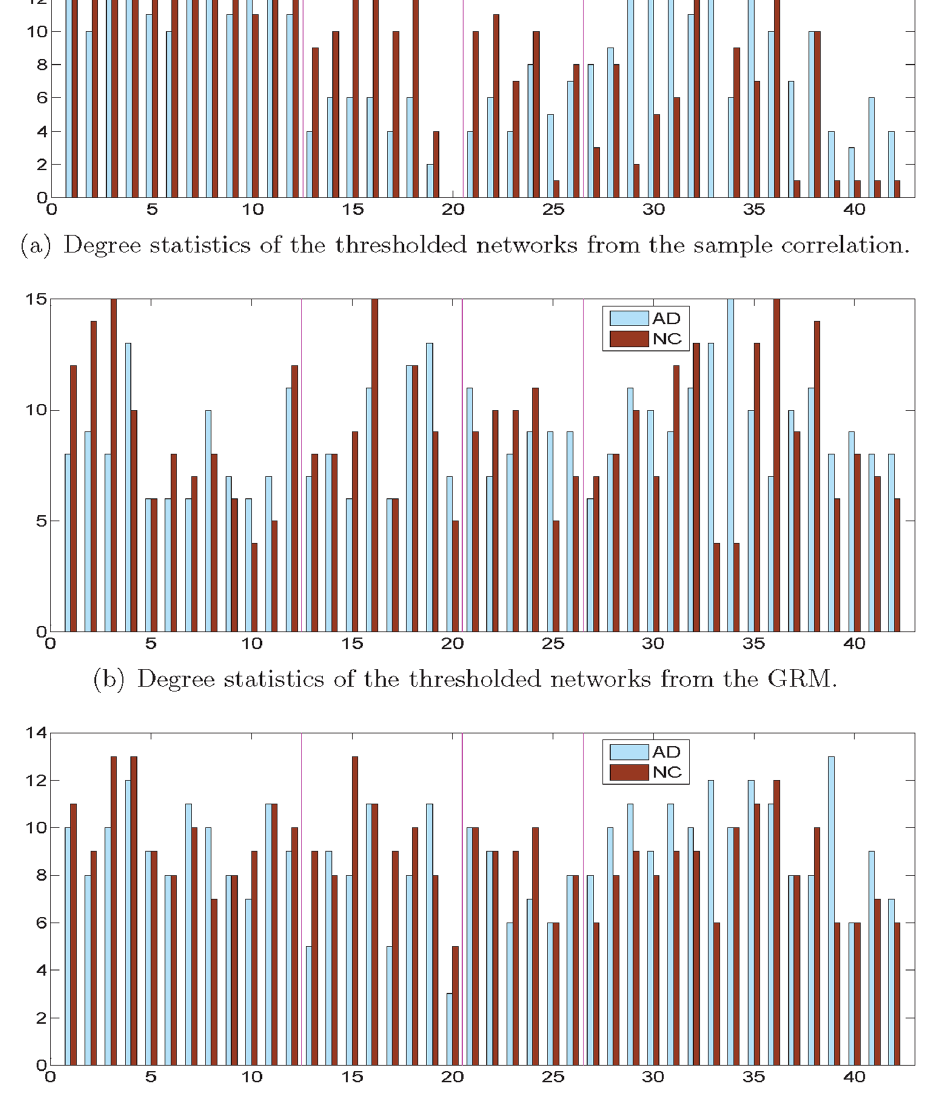
Fig 7. Degree distributions of the thresholded networks. Degree distributions of the thresholded AD and NC networks obtained by different methods. The horizontal and vertical axes correspond to the brain region index and vertex degree, respectively. The magenta lines delineate the four brain lobes: namely, the frontal, parietal, occipital, and temporal lobe (from left to right).